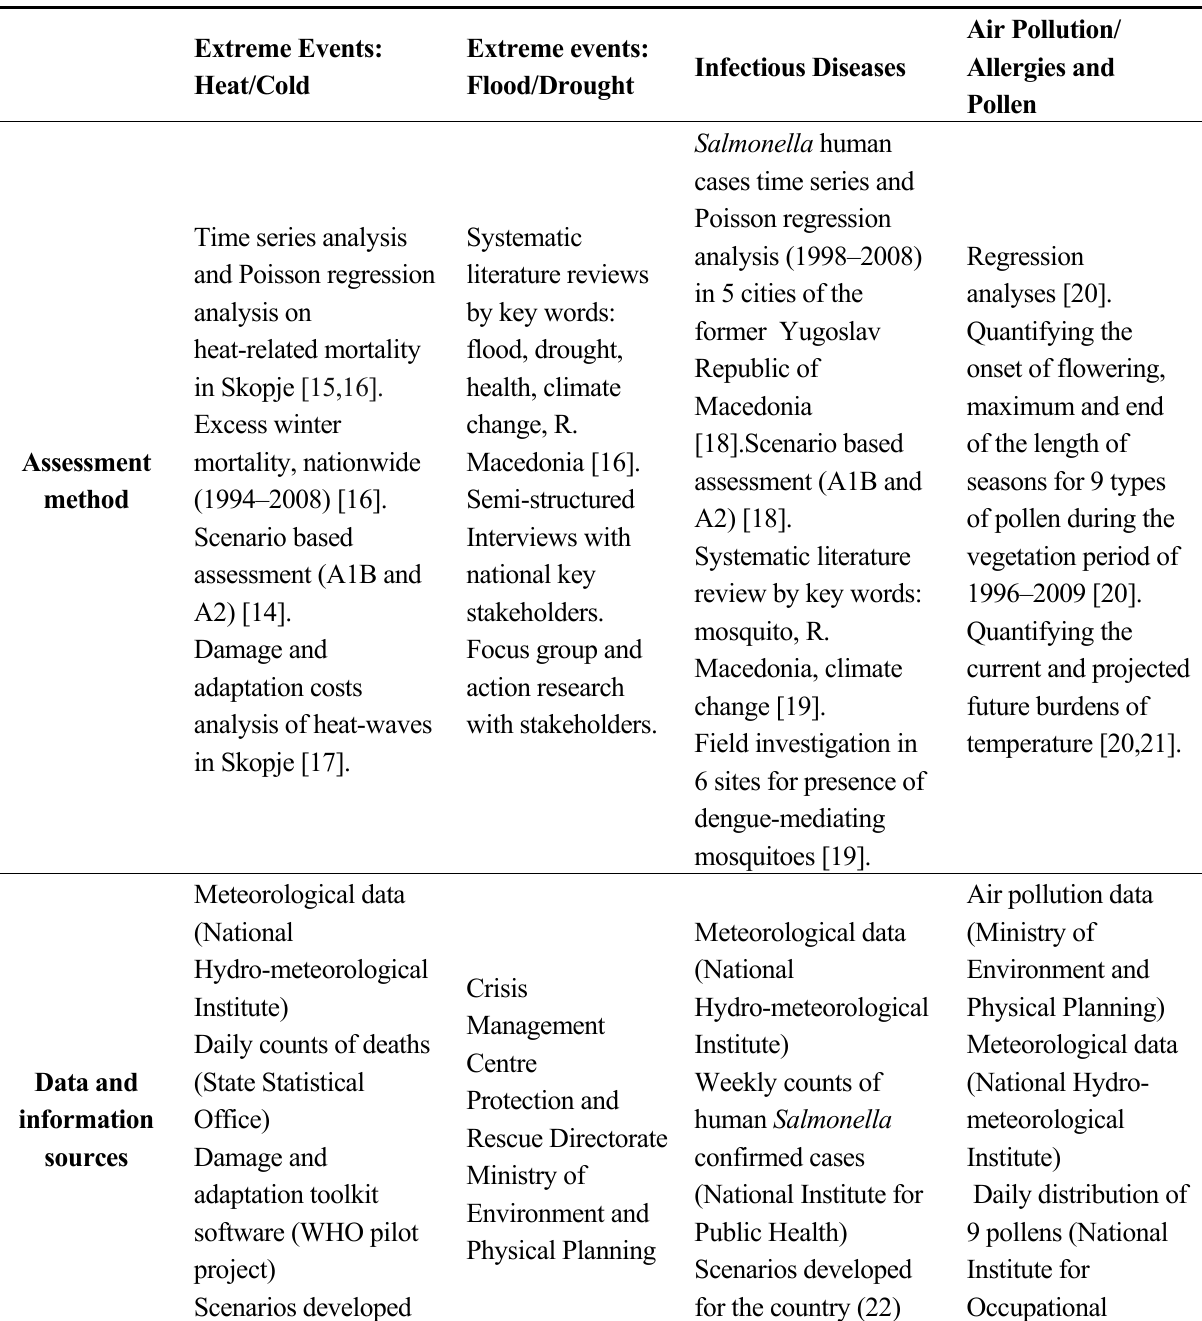
Table 2. Vulnerability and impact assessment approach for climate sensitive diseases and